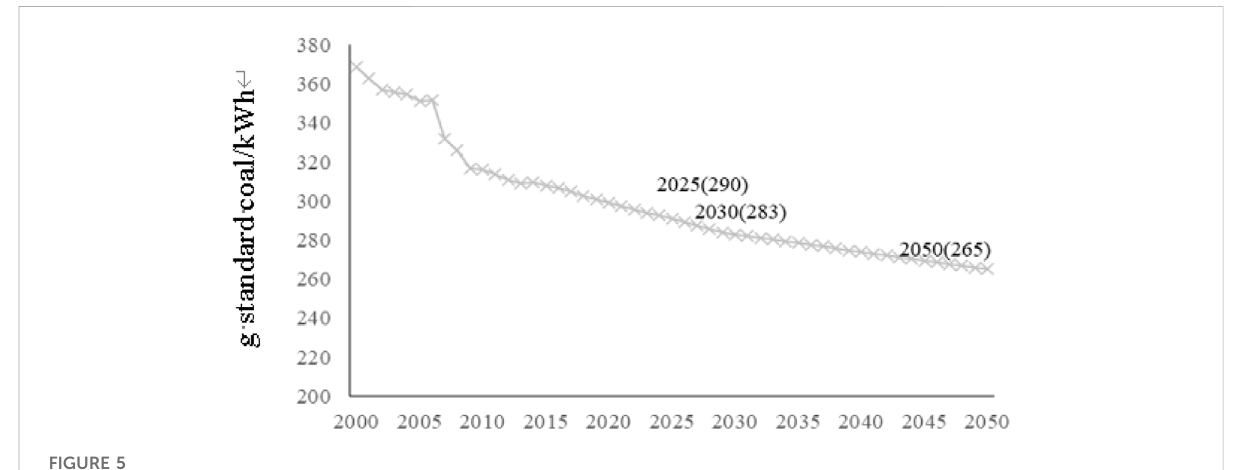
FIGURE 5 Energy ef fi ciency given